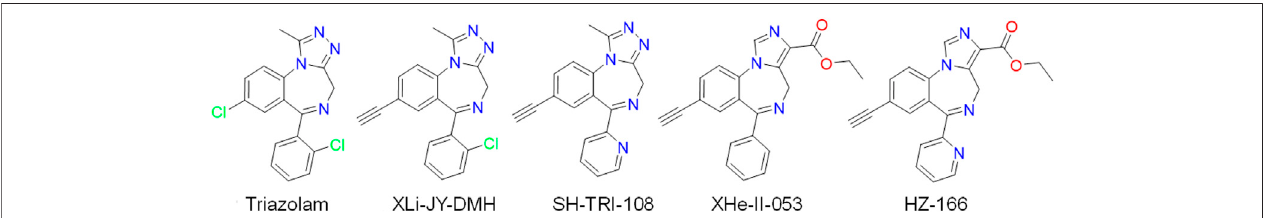
FIGURE1| Chemicalstructuresoftriazolam,8-substitutedtriazolobenzodiazepines(XLi-JY-DMH,SH-TRI-108)and8-substitutedimidazodiazepines(XHe-II-053, HZ-166).